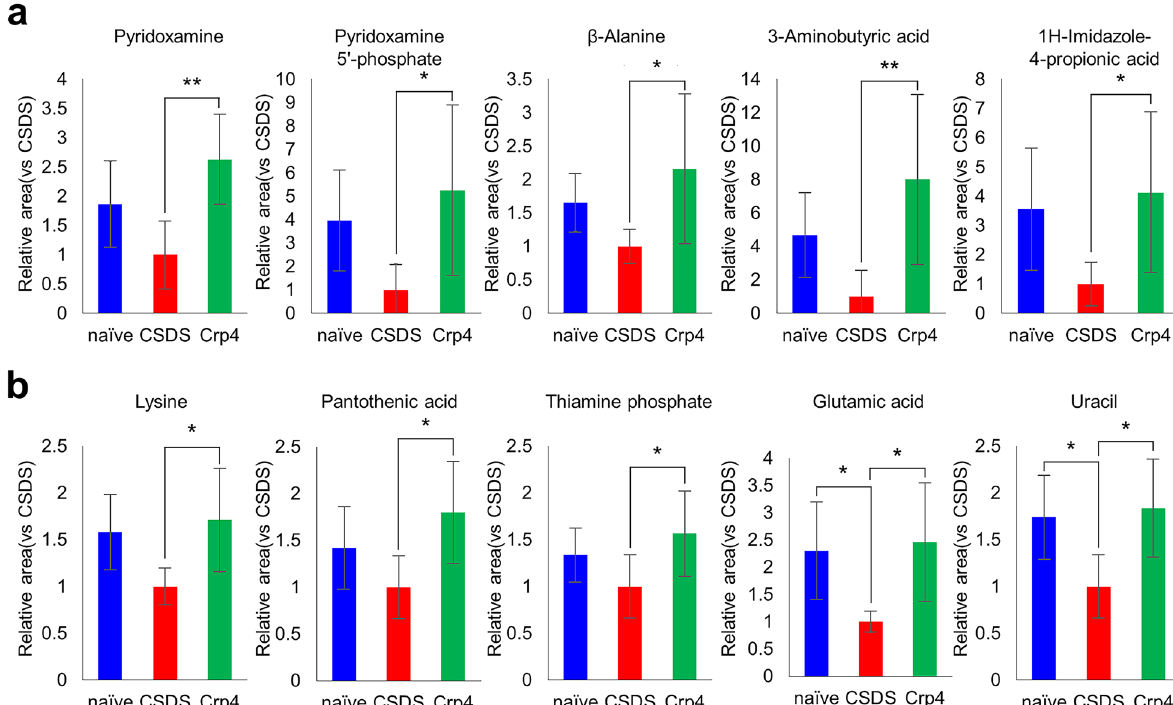
Figure 5. Changes in fecal metabolites correlated with Crps in each group. ( a ) Metabolites significantly correlated with Crps and microbiota (blue metabolites in Table 3). ( b ) Metabolites significantly